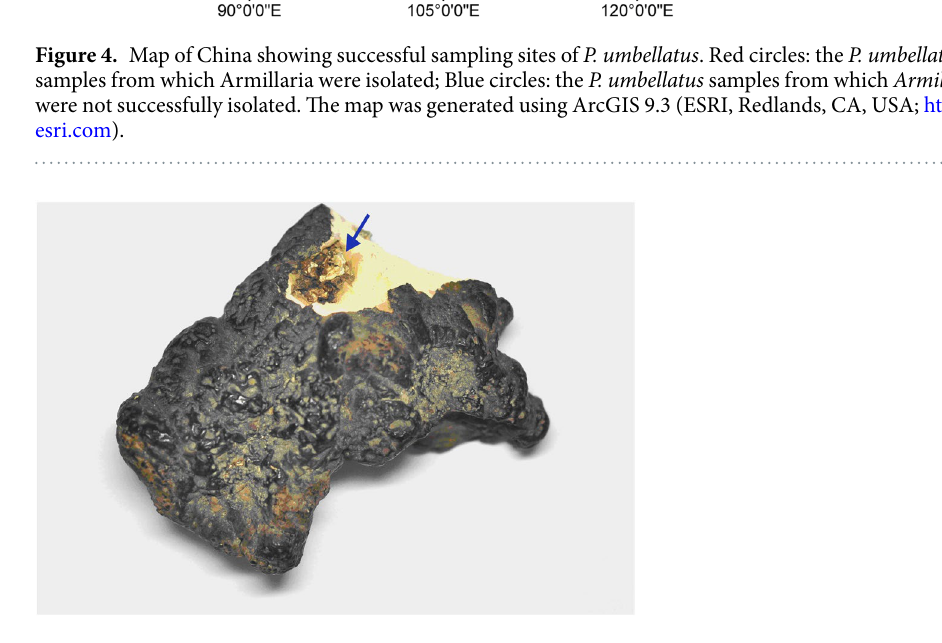
Figure 5. Sclerotia of P. umbellatus bisected from the penetration site of Armillaira rhizomorph on the sclerotial surface. The arrow shows a cavity beneath the surface which contains the penetrated Armillaira